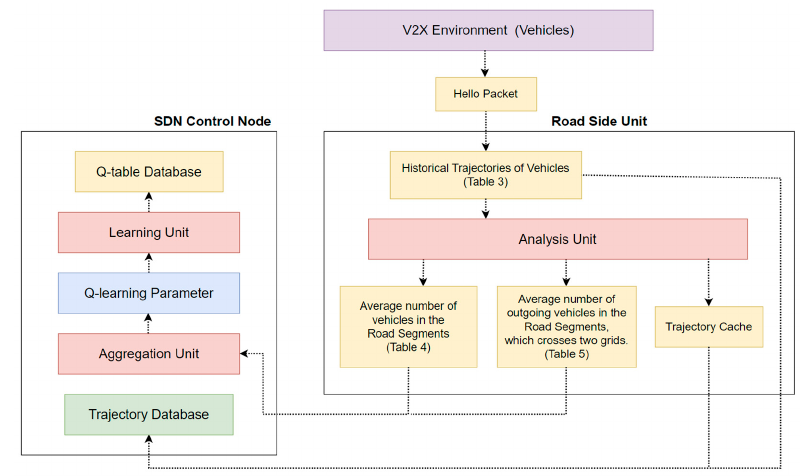
Figure 6. The offline Q-learning training process of SD-QGrid.